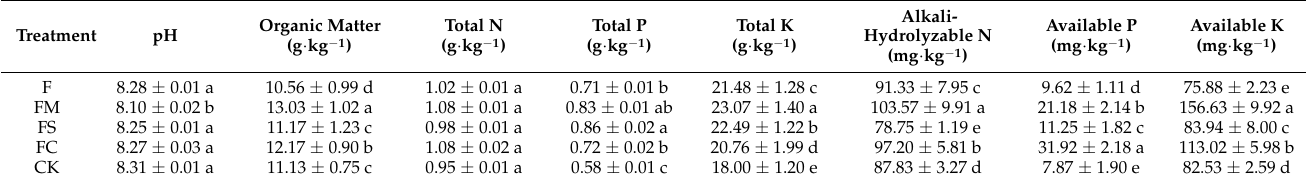
Table 3. Soil chemical properties with different organic